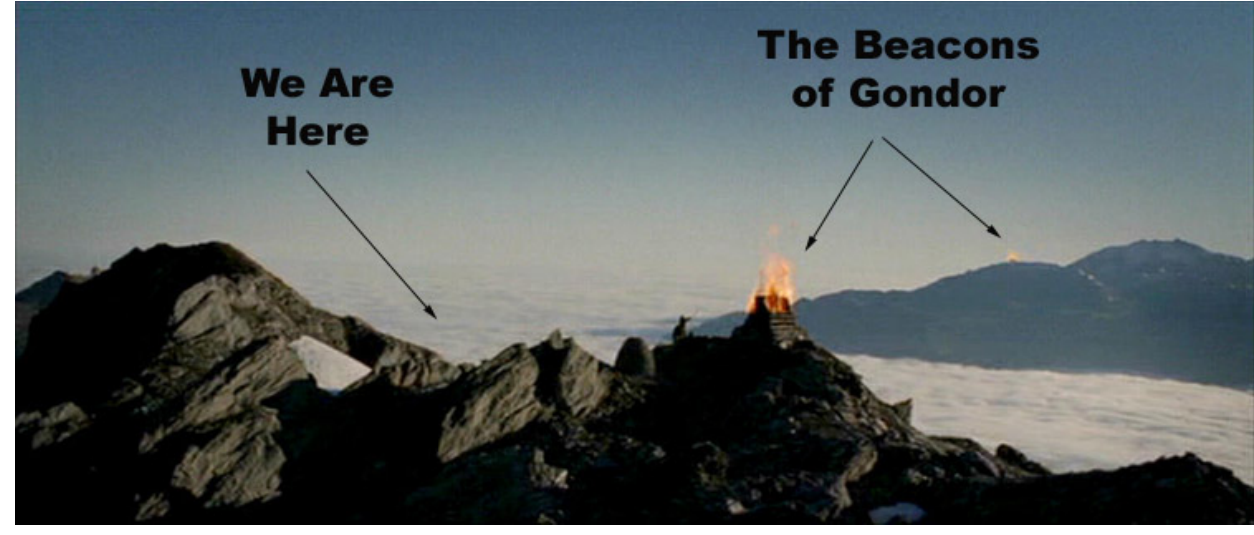
Figure 1. Beacons of Gondor dramatize a metaphor for the advantages of hierarchical com- munication networks that enable search and discovery of a small item in a very large world. If everybody remains trapped under the clouds in isolated valleys everywhere and unable to see elsewhere, then how will we (or software agents) communicate with each other fast enough to find and reach unknown destinations, persons (or agents), and small pieces of information in a large world that grows ever larger all the